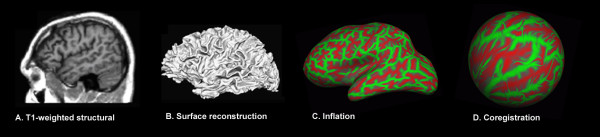
SBM image processing steps: Surface reconstruction and alignment to standard template. A. High-resolution T1-weighted images were processed using FreeSurfer 3.0 to map the cortical surface. The image is a lateral view of the TBI patient's left hemisphere. B. Computerized reconstruction of the gray/white matter boundary. A smoothed and expanded view of the white matter surface is shown. The image has been intensity normalized, skull-stripped and the cerebellum has been removed. C. Inflation of the cortical surface to map gyral and sulcal anatomy. Gyral regions are shown in green and sulcal regions in red. D. Coregistration of the subject's cortical surface to a common spherical template. This step allows the assessment of cortical tissue properties with respect to a normative database using a common coordinate system.